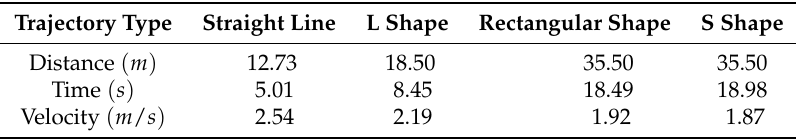
Table 3. Experiments related to the navigation velocities of the multi-robot